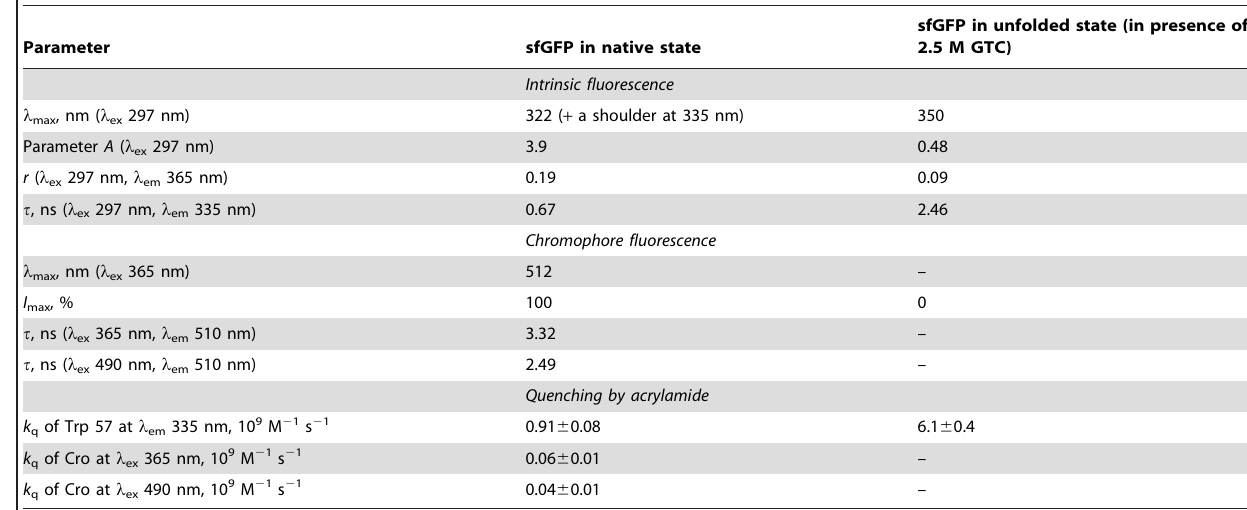
Table 1. Characteristics of intrinsic and chromophore fluorescence of sfGFP in native and unfolded states.